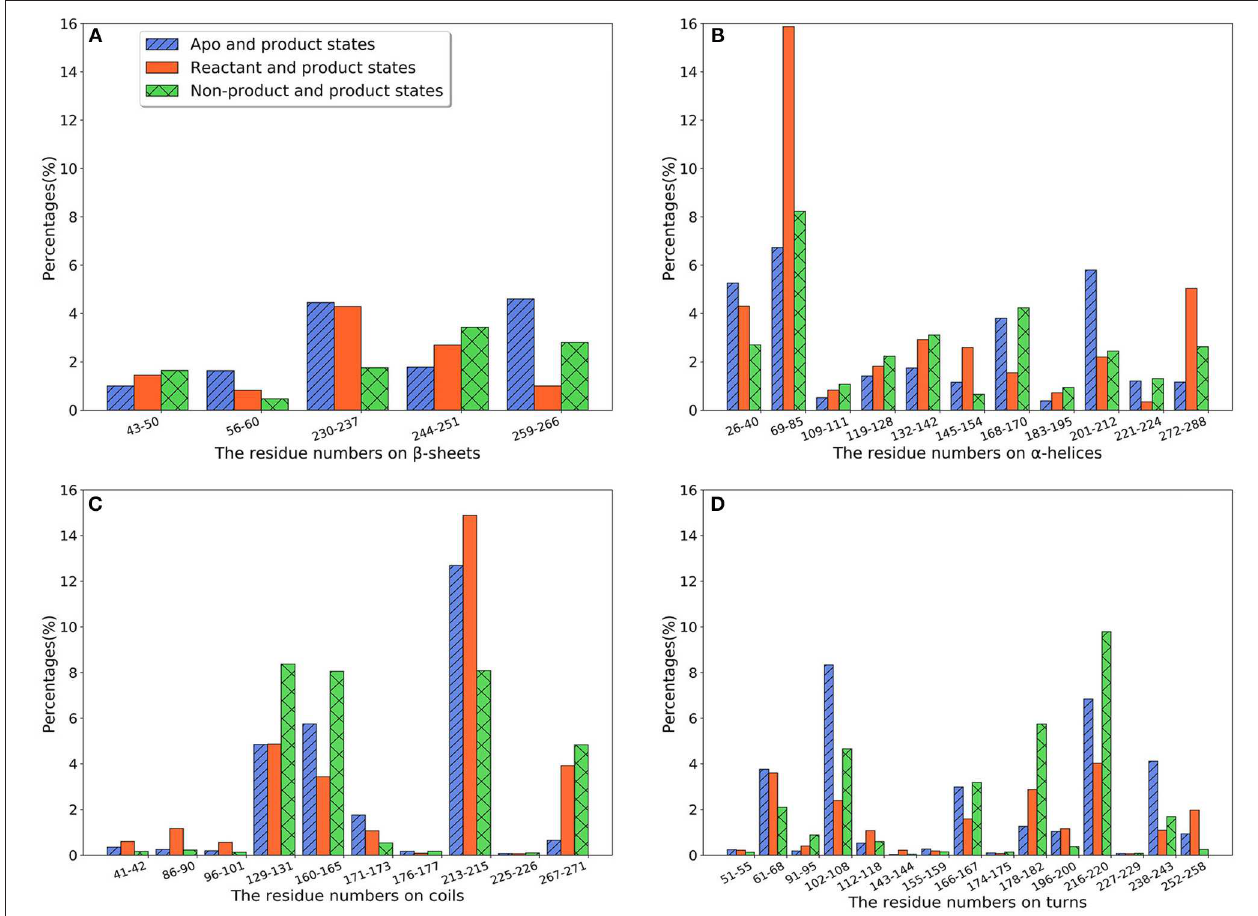
FIGURE 6 | The total feature importance of individual secondary structure in TEM-1: (A) β -sheets; (B) α -helix; (C) Random coils; (D) Turns. Each secondary structure is labeled by residue number. There are five β -sheets and 11 α -helices with varying sizes in TEM-1